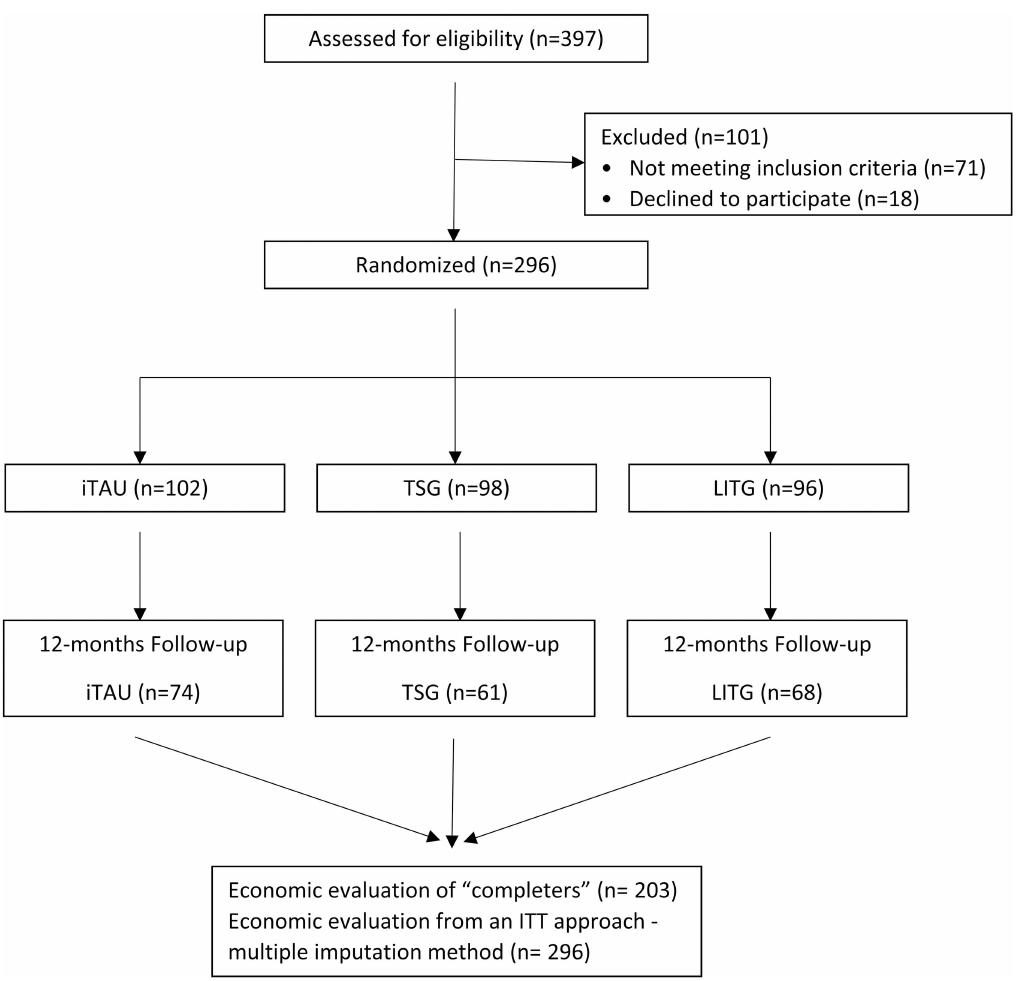
Fig 1. CONSORT flowchart of the participants in the economic evaluation. iTAU: improvedtreatment as usual; TSG: totally self-guidedInternet-based program; LITG: low-intensity therapist-guided Internet-based program.